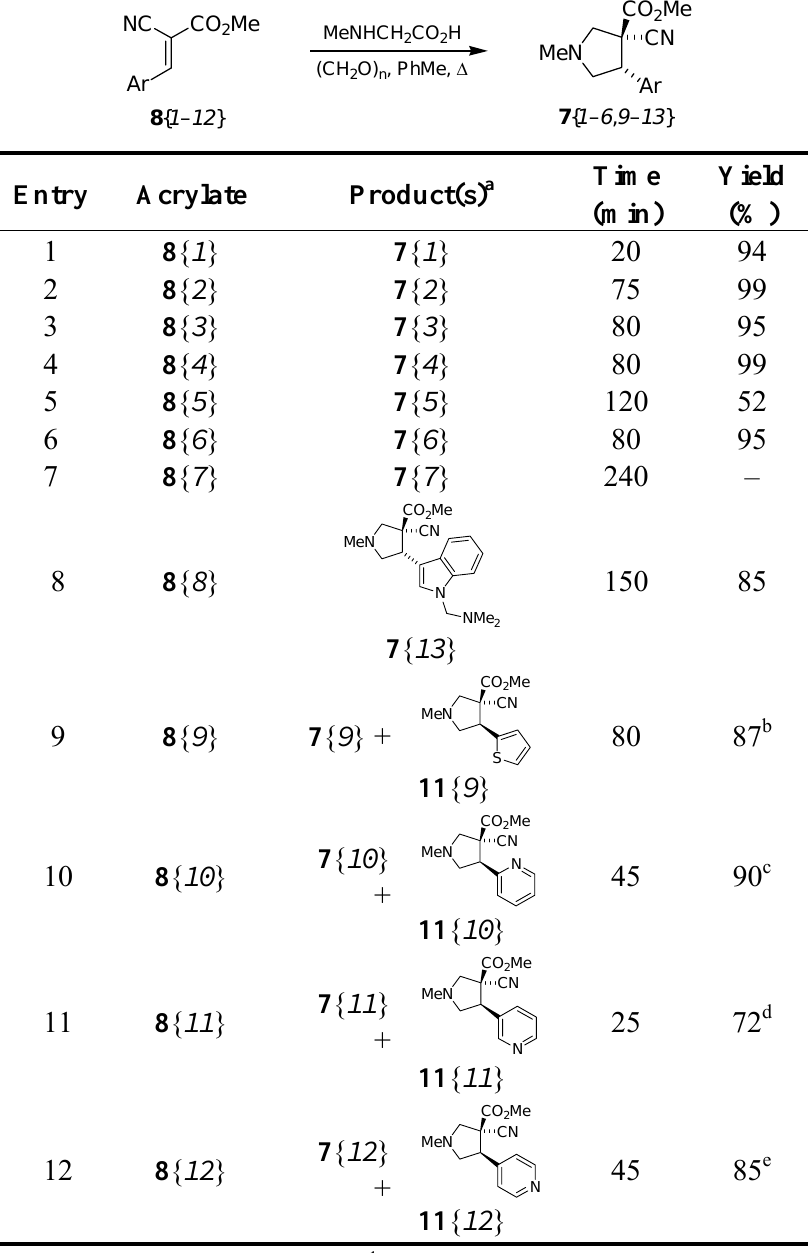
Table 2. 1,3-Dipolar cycloaddition reaction to form the pyrrolidine-core structures 7